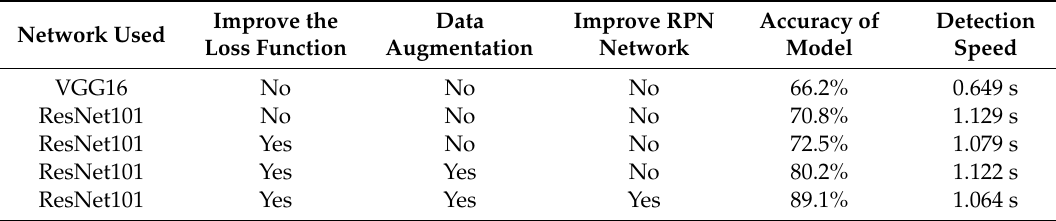
Table 1. Comparison of model e ff ect in di ff erent improvement